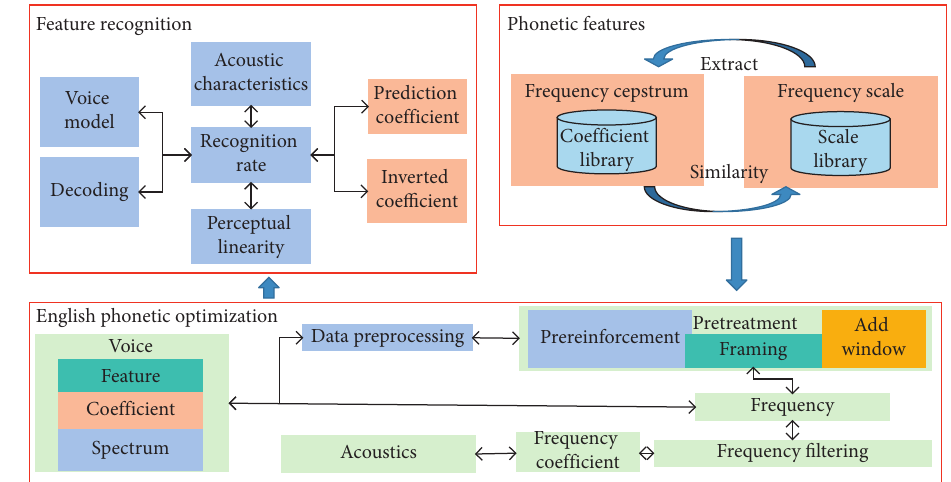
Figure 2: English speech rationality optimization recognition feature extraction process.